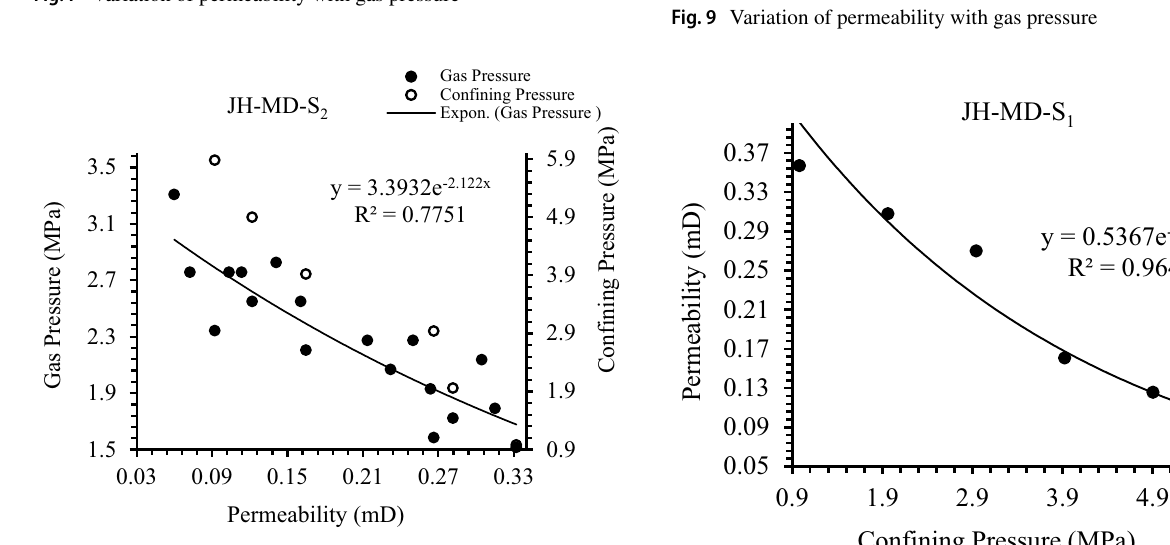
Fig. 7 Variation of permeability with gas pressure